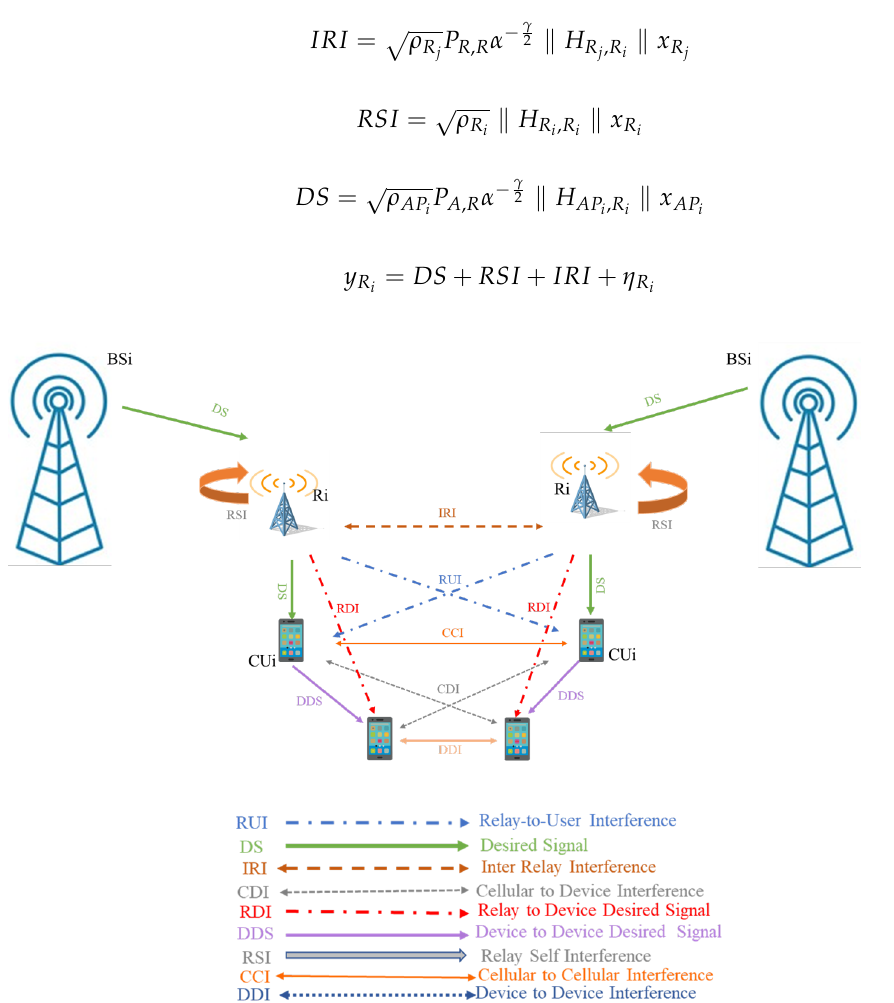
Figure 1. Multi-tier heterogeneous